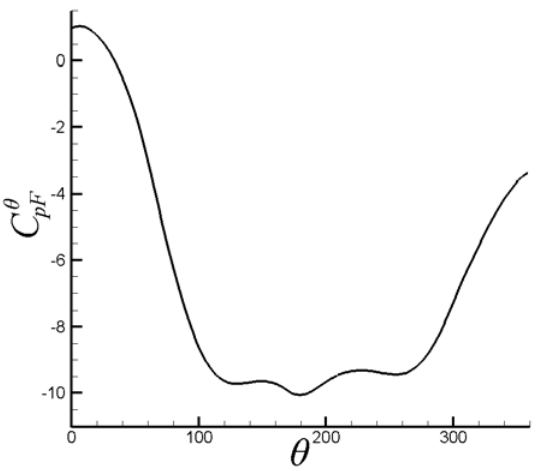
θ C on the surface of cylinder with the on the surface of cylinder with the pF pF